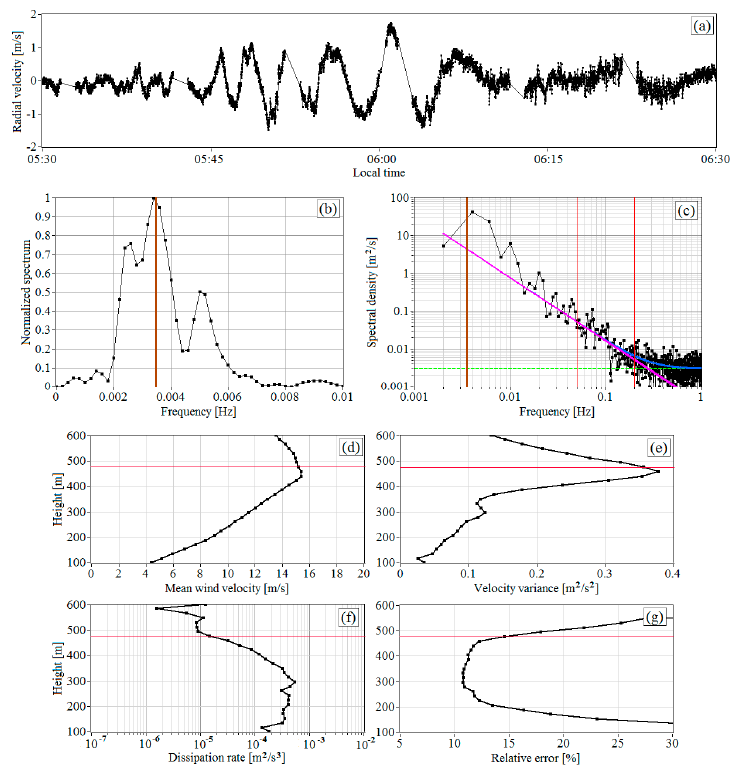
Figure 12. Time series ( a ), normalized spectrum in the low-frequency range ( b ), and spectral density of fluctuations ( c ) of the radial velocity at a height of 477 m; vertical profiles of the mean wind velocity ( d ), variance of the vertical component of the wind velocity vector ( e ), turbulent energy dissipation rate ( f ), and relative error of lidar estimation of the dissipation rate ( g ). Red lines in plots ( d – g ) mark height 477 m. Measurements from 05:42 to 06:12 LT on 2